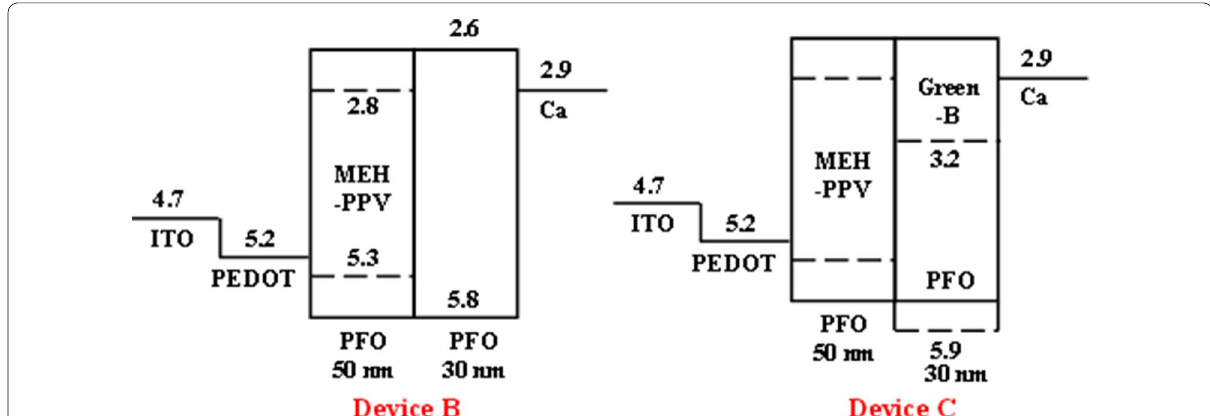
Fig. 5 Energy band diagrams of the homojunction based WPLEDs (Reproduced with permission from Ref. [21] Copyright 2004 ©Applied Physics